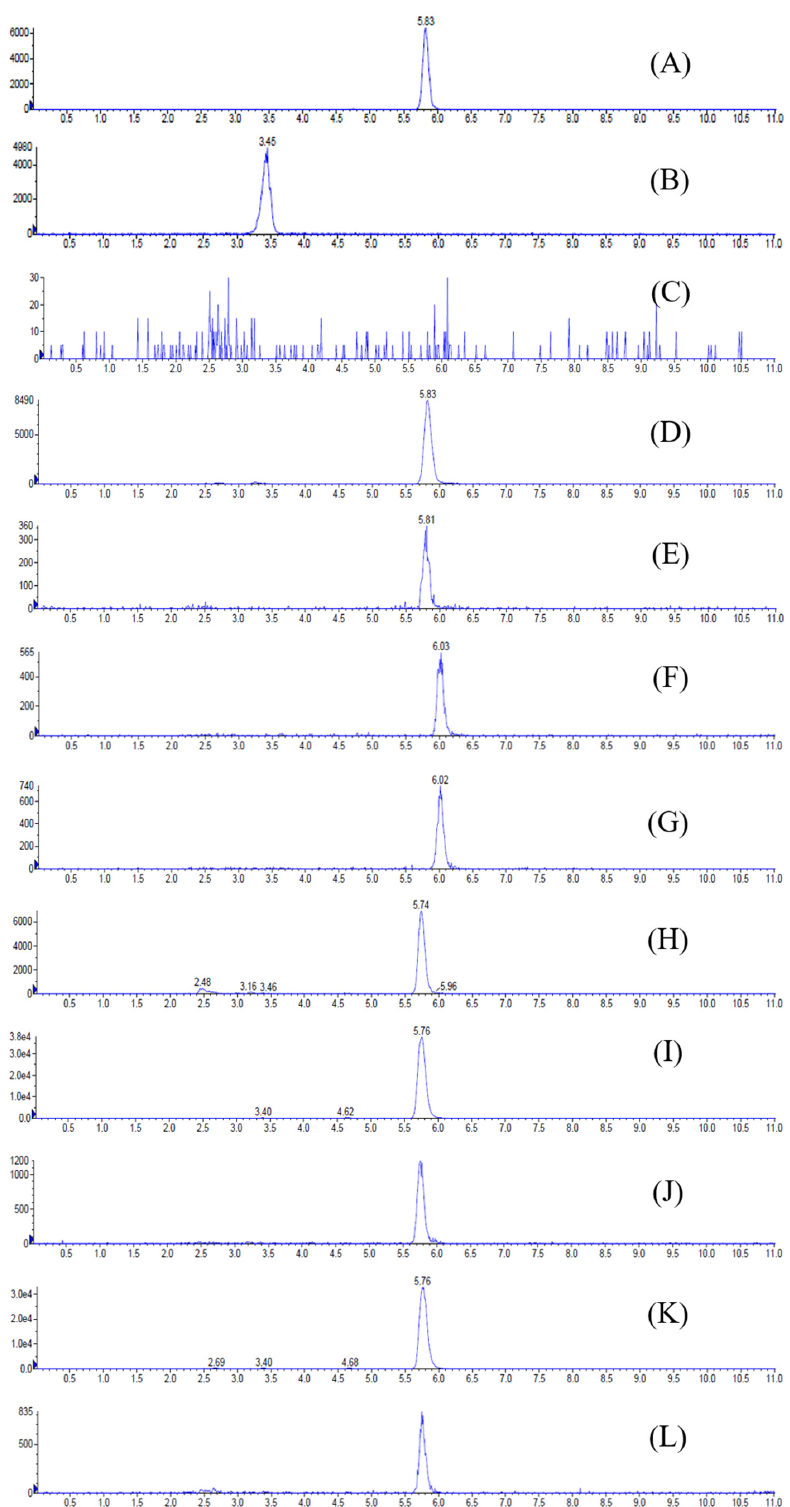
Figure 2. Representative HPLC Chromatograms for ( A ) erinacine A (200 ng/mL), ( B ) internal standard (2,4,5-trimethoxybenzaldehyde; 50 ng/mL), ( C ) blank rat plasma, ( D ) rat plasma sample obtained at 360 min after a 2.381 g/kg BW oral dose of Hericium erinaceus mycelia extract (equivalent to 50 mg/kg BW of erinacine A), ( E ) brain, ( F ) heart, ( G ) lung, ( H ) liver, ( I ) kidney, ( J ) stomach, ( K ) small intestine, and ( L ) large intestine samples obtained 4 h after a 2.381 g/kg BW oral dose of H. erinaceus mycelia